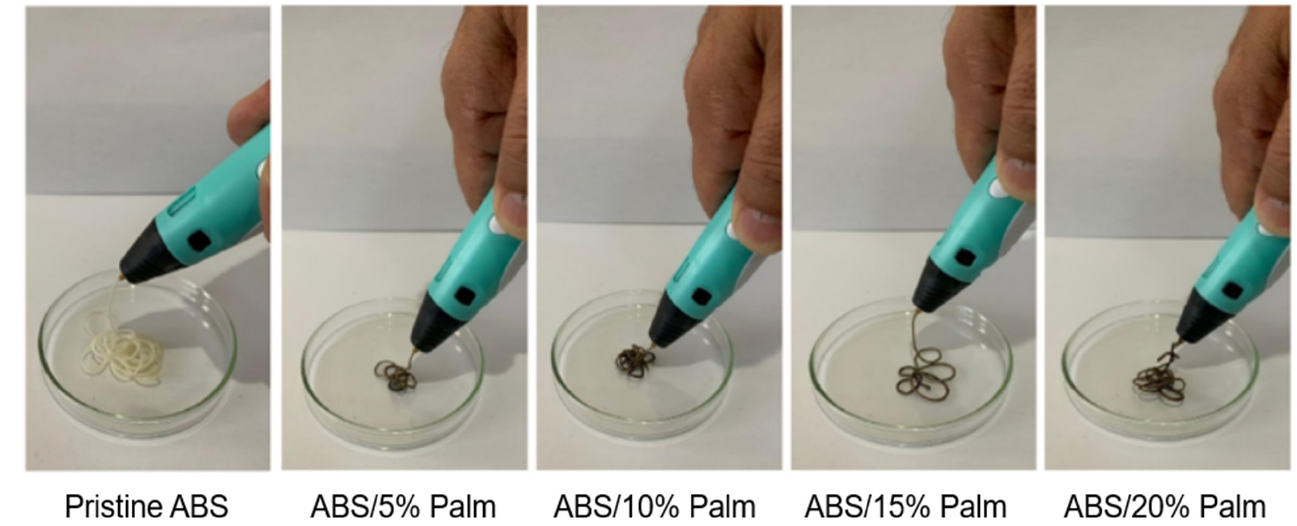
Figure 11. Fiber-reinforced filament composites from palm waste with acrylonitrile butadiene styrene using a 3D printing pen “Reprinted/adapted with permission from Ref. [70]. Copyright © 2022, Elsevier”.